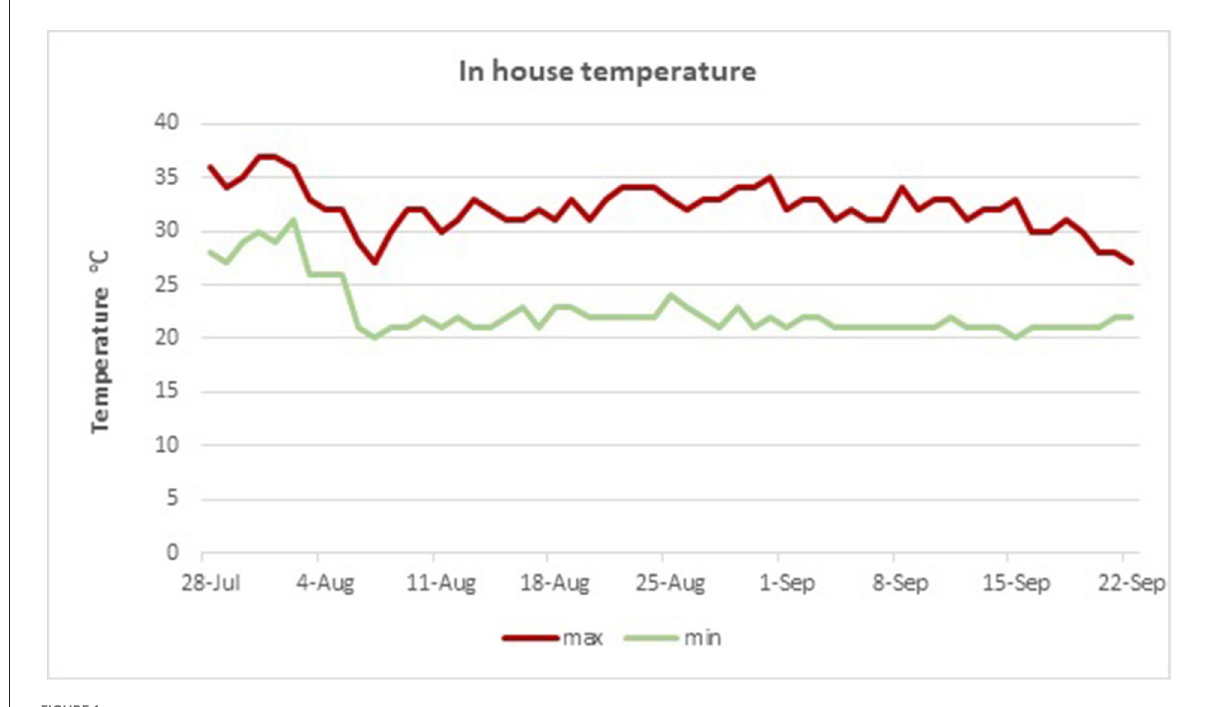
FIGURE1 Measured in house minimum and maximum temperatures during the experimental